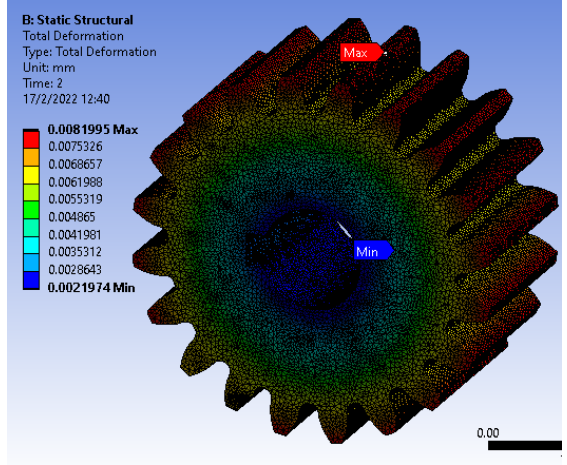
Figure 3. Pinion deformation.